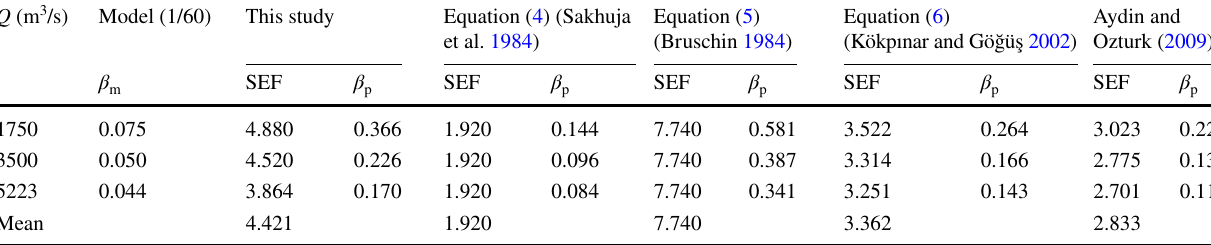
Table 3 Scale effect factors and calculation of prototype air entrainment rates Q (m 3